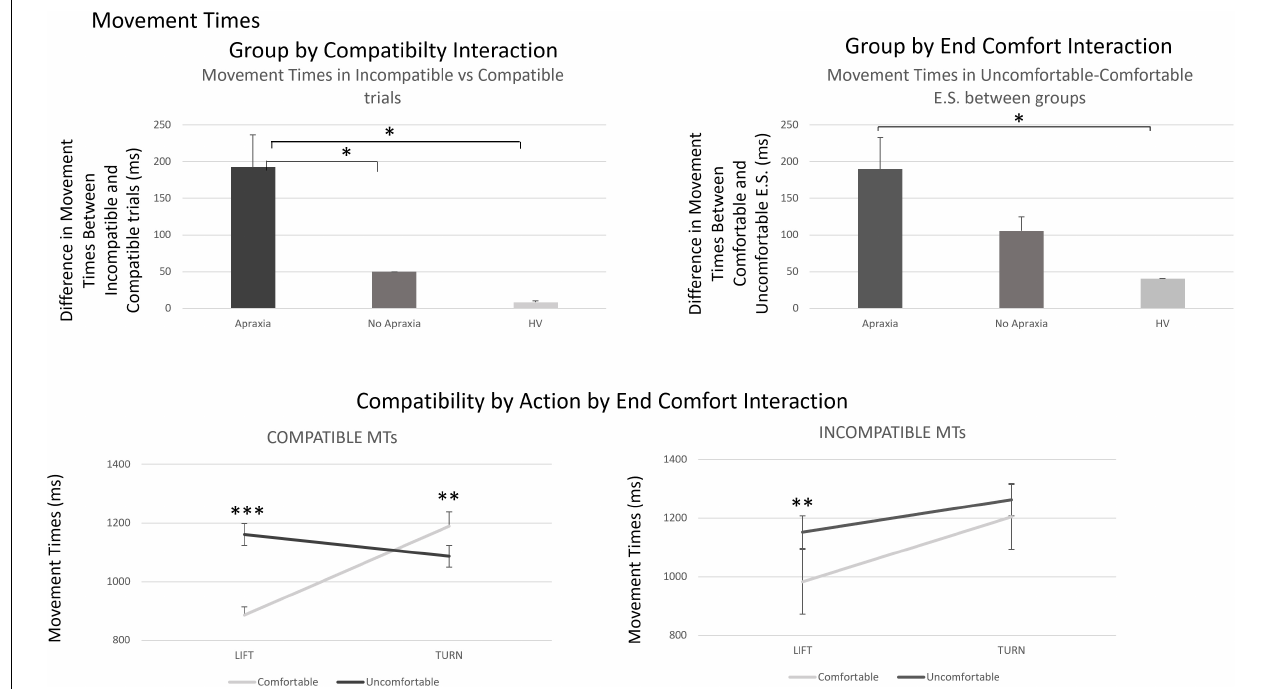
FIGURE 4 | Movement times – interactions by group and three-way interaction of compatibility by action by end-state comfort effects. The top panel demonstrates the group by compatibility and end-state comfort effects in MTs, which reflect a similar process to what was described for error rates in Figure 2 . The bottom panel describes the compatibility by action by end-comfort interaction identified for MTs. This arose because of a significant difference in end-state comfort effects for lift compared to turn actions in compatible trials, which was only present in lift, and not turn, actions, in incompatible trials. The four-way interaction identified that the effect in compatible trials was driven by patients with ideomotor apraxia, indicating an increased sensitivity to end-state comfort effects in compatible trials for these patients. ∗ p < 0.05, ∗∗ p < 0.001, and ∗∗∗ p <